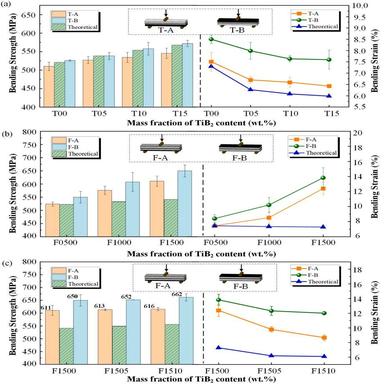
Bending strength and strain of TiB2/Al7050 FGM:(a) TFGM; (b) FFGM with interlayer of H00; (c) FFGM with different interlayer.